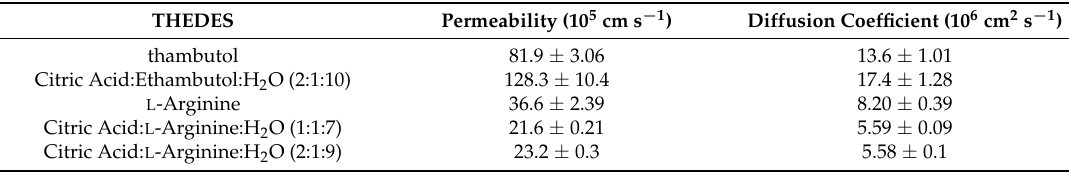
Table 2. Permeability and diffusion coefficients calculated for the different